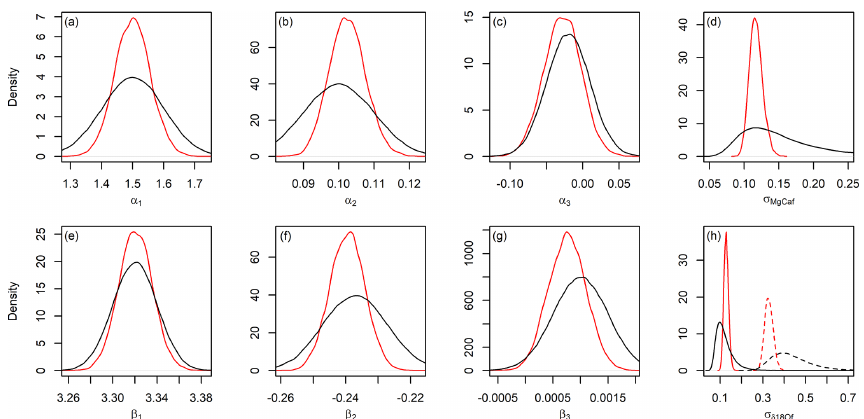
Figure 5. Prior (black) and posterior (red) distributions for Oridorsalis umbonatus Mg / Ca (a–d) and Cibicidoides sp. δ 18 O (e–h) proxy model parameters (ref. Eqs. 2 and 3, respectively) in the site 806 analysis. Solid and dashed lines in panel (h) show standard deviations of the calibration relationship prior to and following the 800ka transition, respectively.